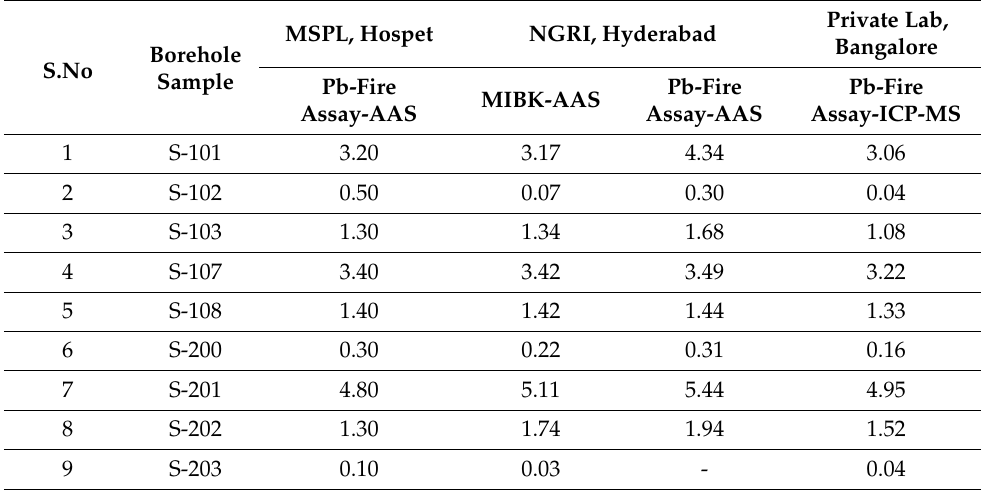
Table 3. Gold values ( µ g/g) in borehole samples obtained by different techniques at different laboratories in India in a gold exploration study. Private Lab, MSPL, Hospet NGRI, Hyderabad Bangalore Borehole S.No Sample Pb-Fire Pb-Fire Pb-Fire MIBK-AAS Assay-AAS Assay-ICP-MS Assay-AAS 1 S-101